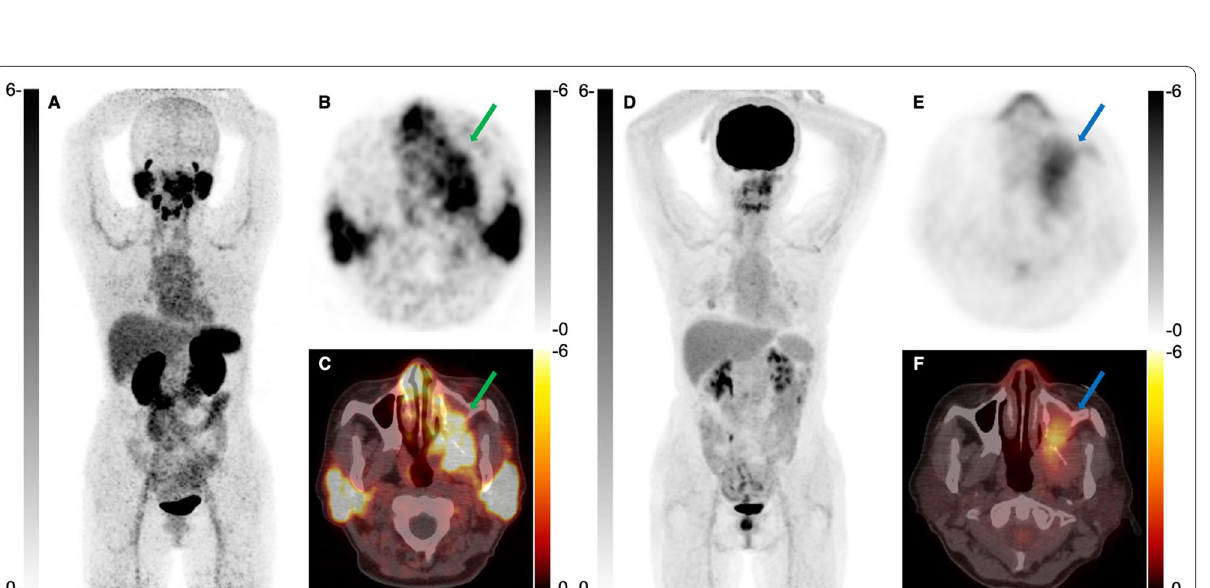
ACC Adenoid cystic carcinoma * Difference is statistically significant